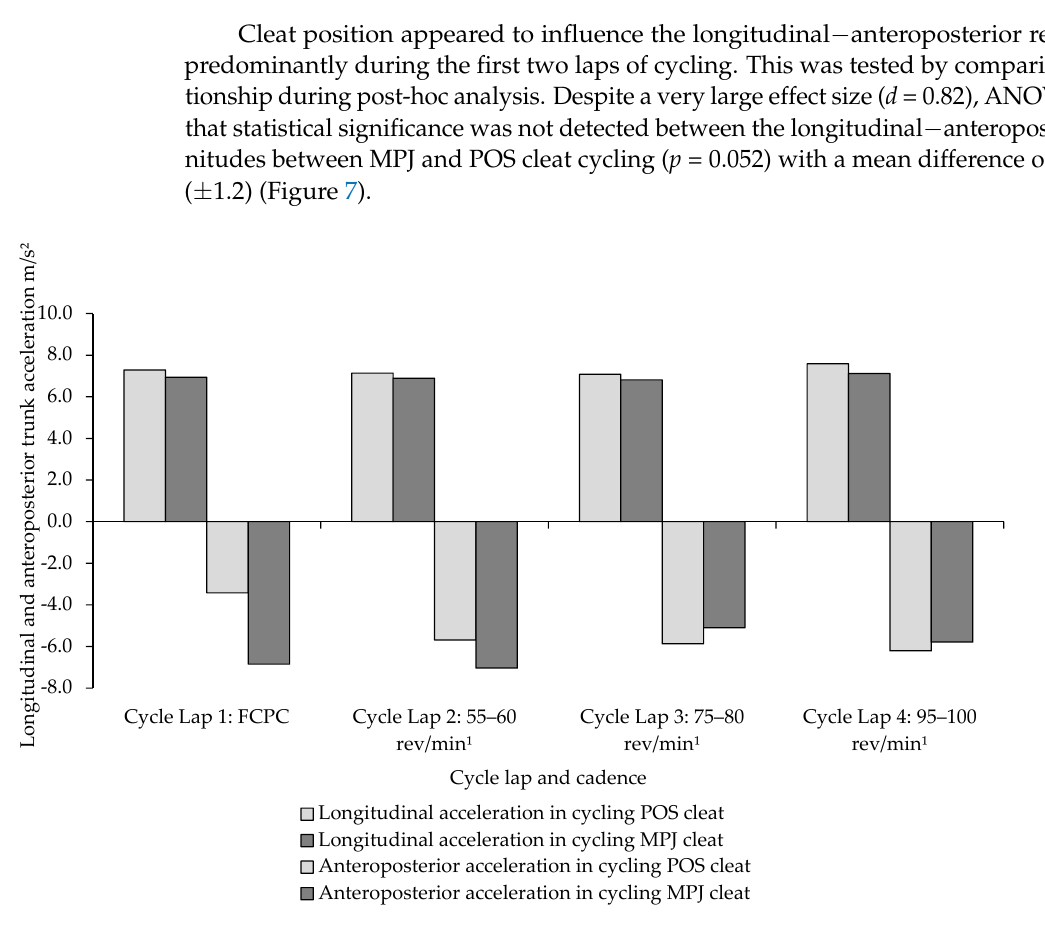
Figure 7. Comparison of the longitudinal − anteroposterior trunk acceleration relationship between MPJ and POS cleat positions in 20 km of cycling .